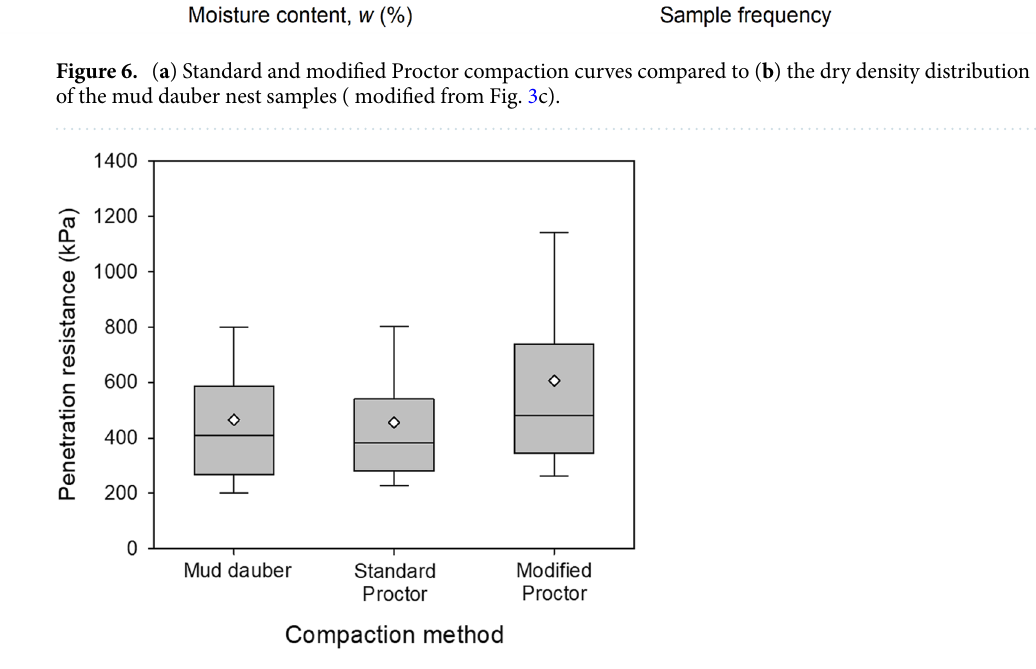
Figure 7. Comparison of the penetration resistances between different compaction